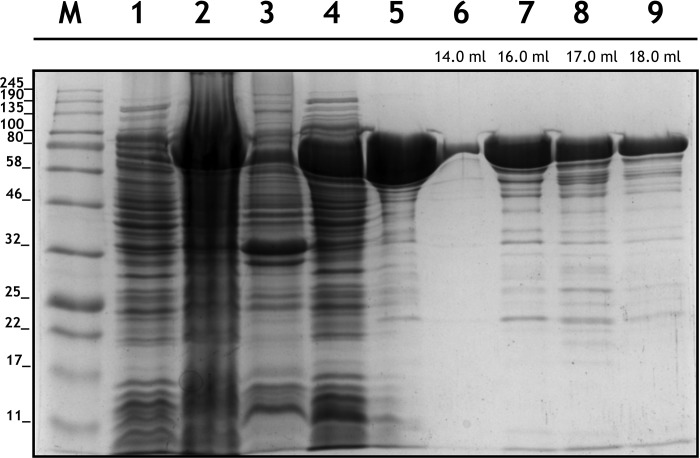
SDS-PAGE gel depicting FCS1 expression and purification steps.Lane M, Molecular Marker (Color Prestained Protein Standard, Broad Range, NEB); lane 1, culture supernatant fraction immediately after IPTG addition; lane 2, cell pellet after 4 hours of IPTG-induced expression (before lysis for purification); lane 3, leftover cell pellet after lysis; lane 4, crude extract (35 μg); lane 5, affinity chromatography fraction (10 μg); lanes 6 (2 μg), 7 (12 μg), 8 (5 μg) and 9 (3 μg) size-exclusion chromatography fractions (elution volumes are shown). See in the supplementary material the metal affinity and size-exclusion column chromatograms (S2 Fig).